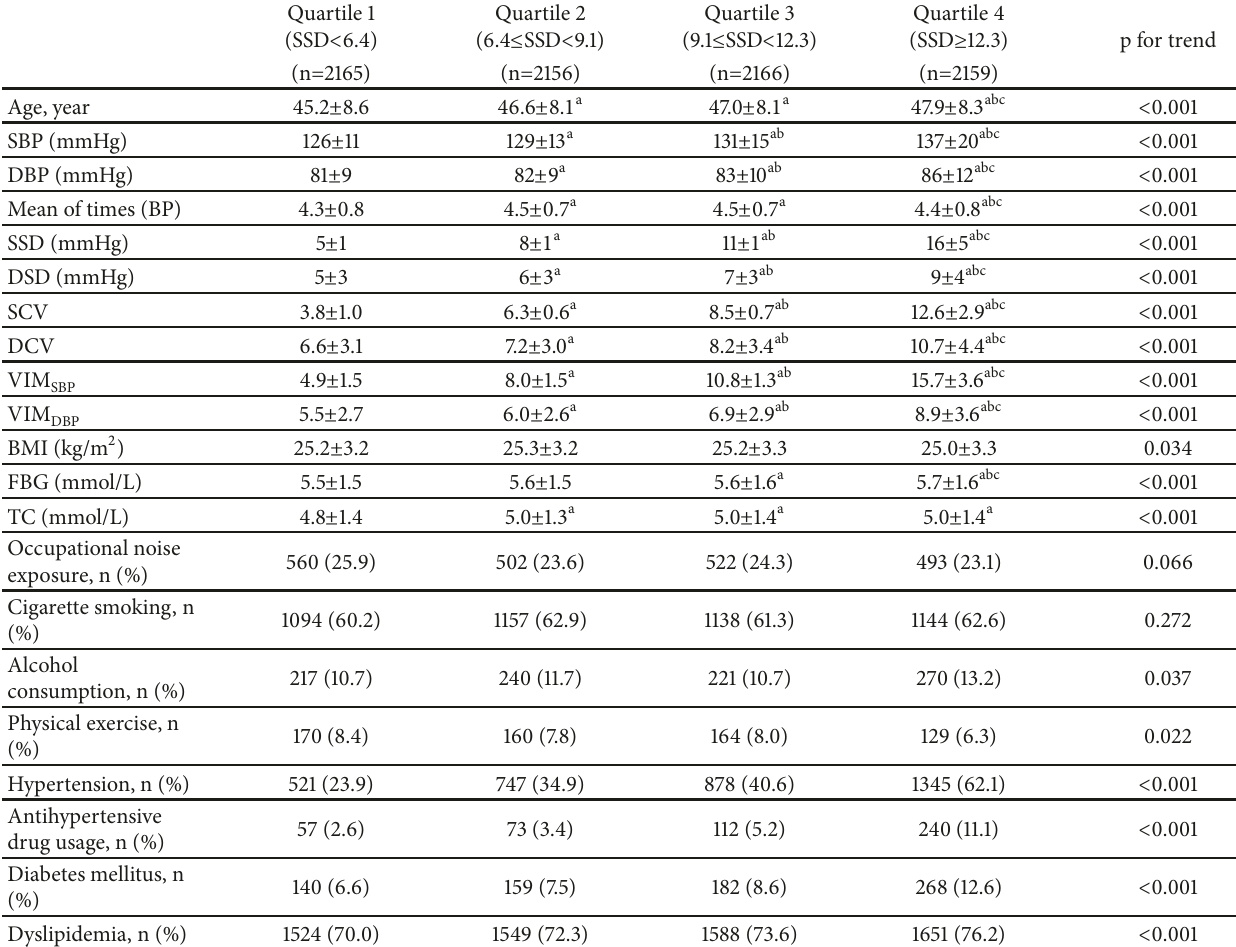
Table 1: Clinical characteristics of participants in different BPV groups.